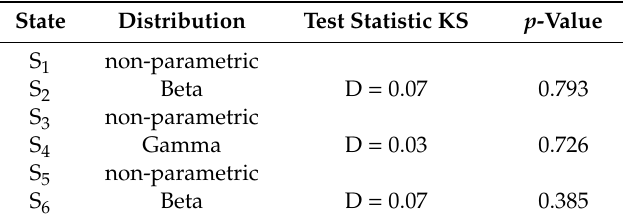
Table 2. Estimated model parameters according to Weibull and Beta distributions. Table 3. Goodness of fit results for states S 1 –S 6